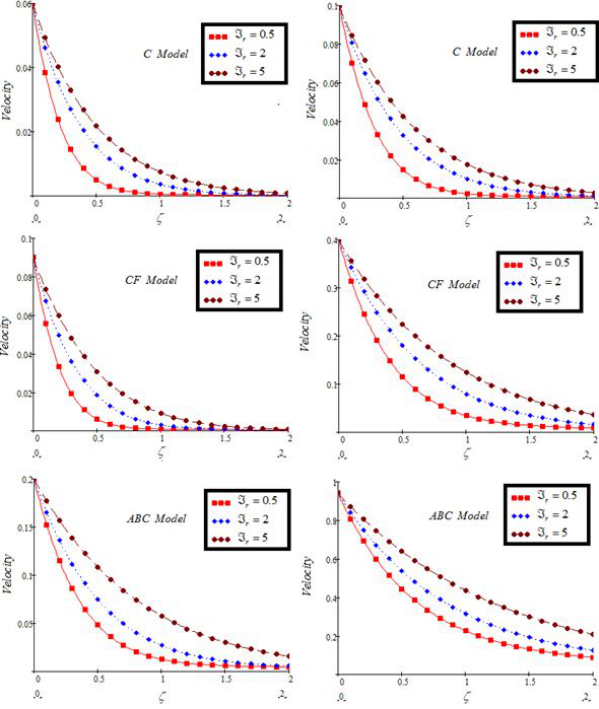
Figure 10: Velocity profile for FD’s with variation of (cid:61) r and Gr = 5, Gm = 2, M =